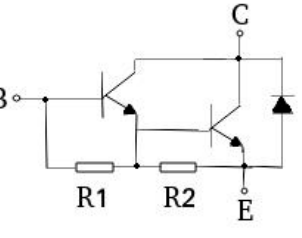
Figure 6. The equivalent circuit presenting the internal structure of NPN Silicon Darlington type Transistor KSH122 manufactured by Fairchild Semiconductor finally used to control the electromagnetic locks (B stands for base, C for collector, and E for emitter).